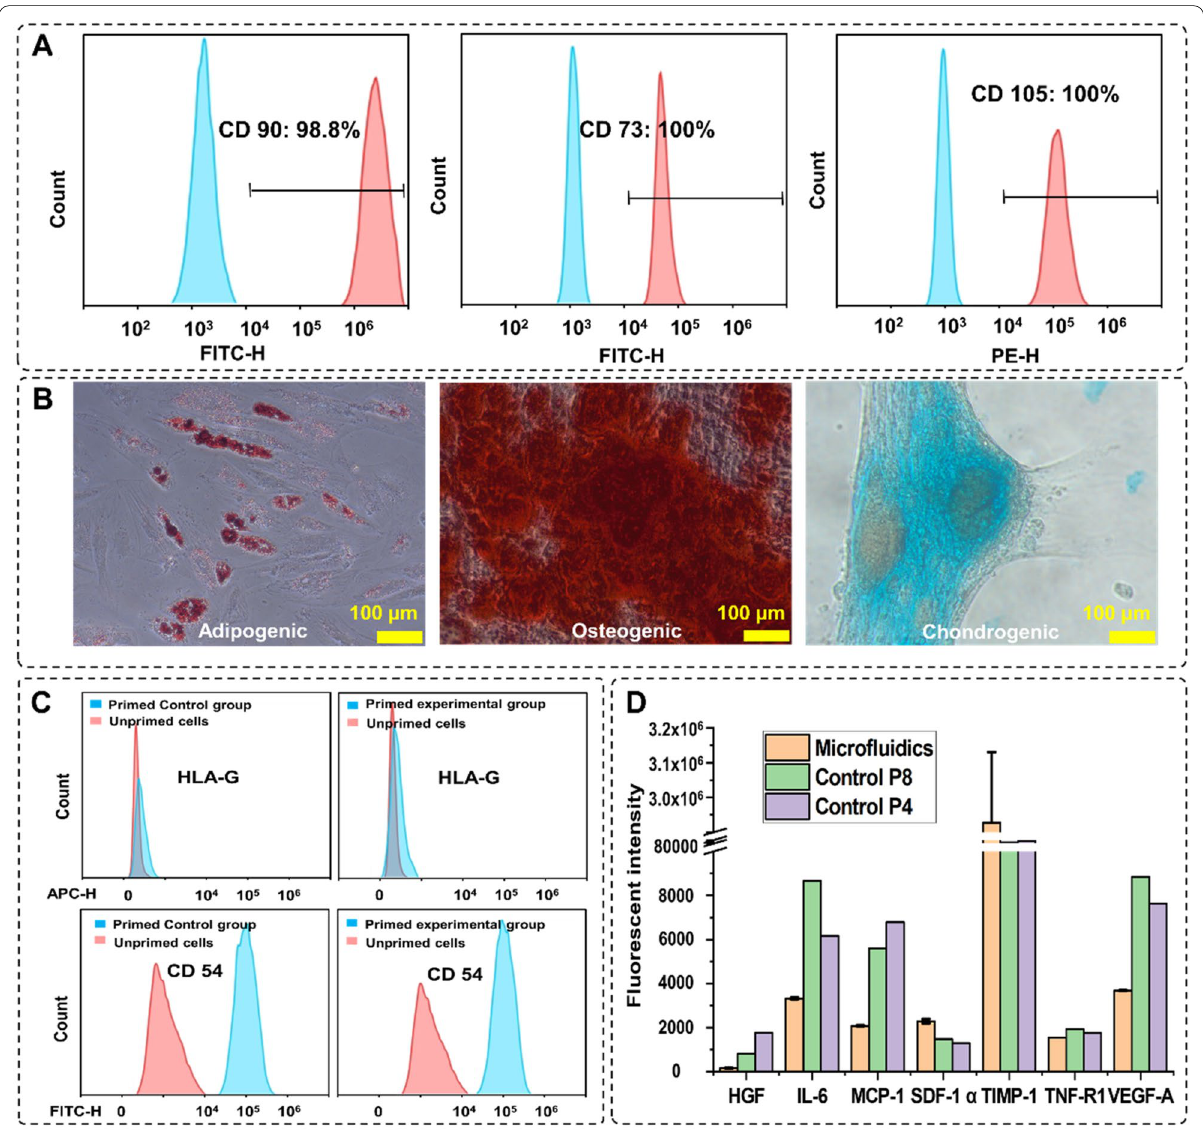
Fig. 5 MSCs characterisation after harvesting. A Expression of the MSCs surface markers CD90, CD73, and CD105 after 3 passages of indicated cells preserve their stemness after harvesting. B Multipotency assay of harvested cells using Oil red (left), Alizarin red (middle), and Alcian blue (right) showed the cells maintained their capacity to differentiate into different cell types. C The expression level of the surface therapeutic proteins of the experimental group. The changes in the expression level of HLA-G and CD54 were similar in both groups. D Comparison of the cytokine secretion profile of MSCs harvested from the microcarriers with microfluidic system and the passage 4, passage 8 planar flask cultured